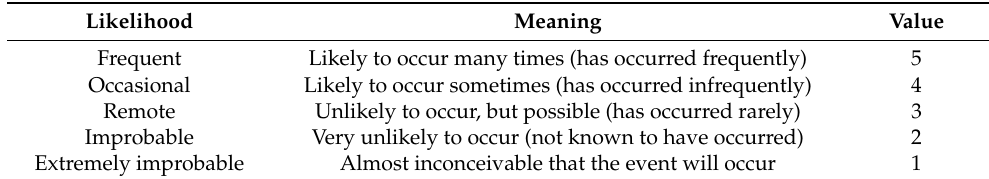
Table 2. Safety risk probability [30].